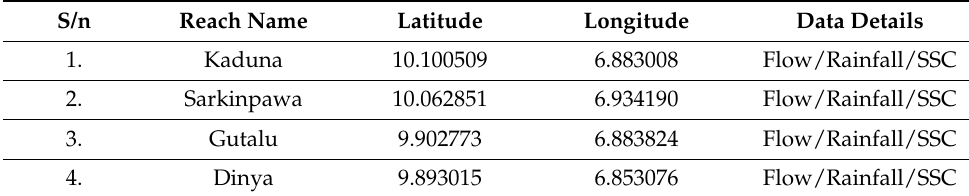
Table 2. Geographic location of sample points/station for